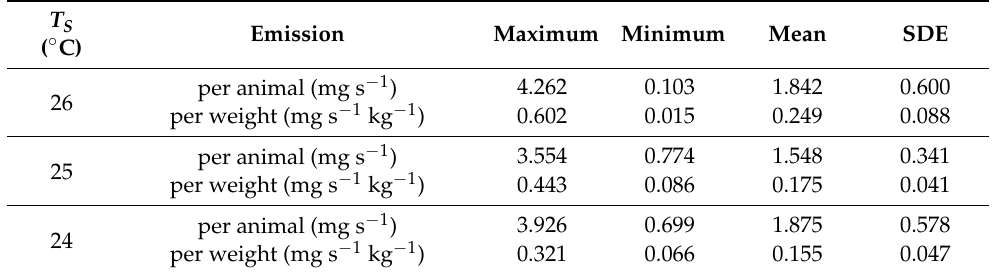
Table 4. Main statistics for CO 2 emissions from the building per animal and per weight for different setpoint